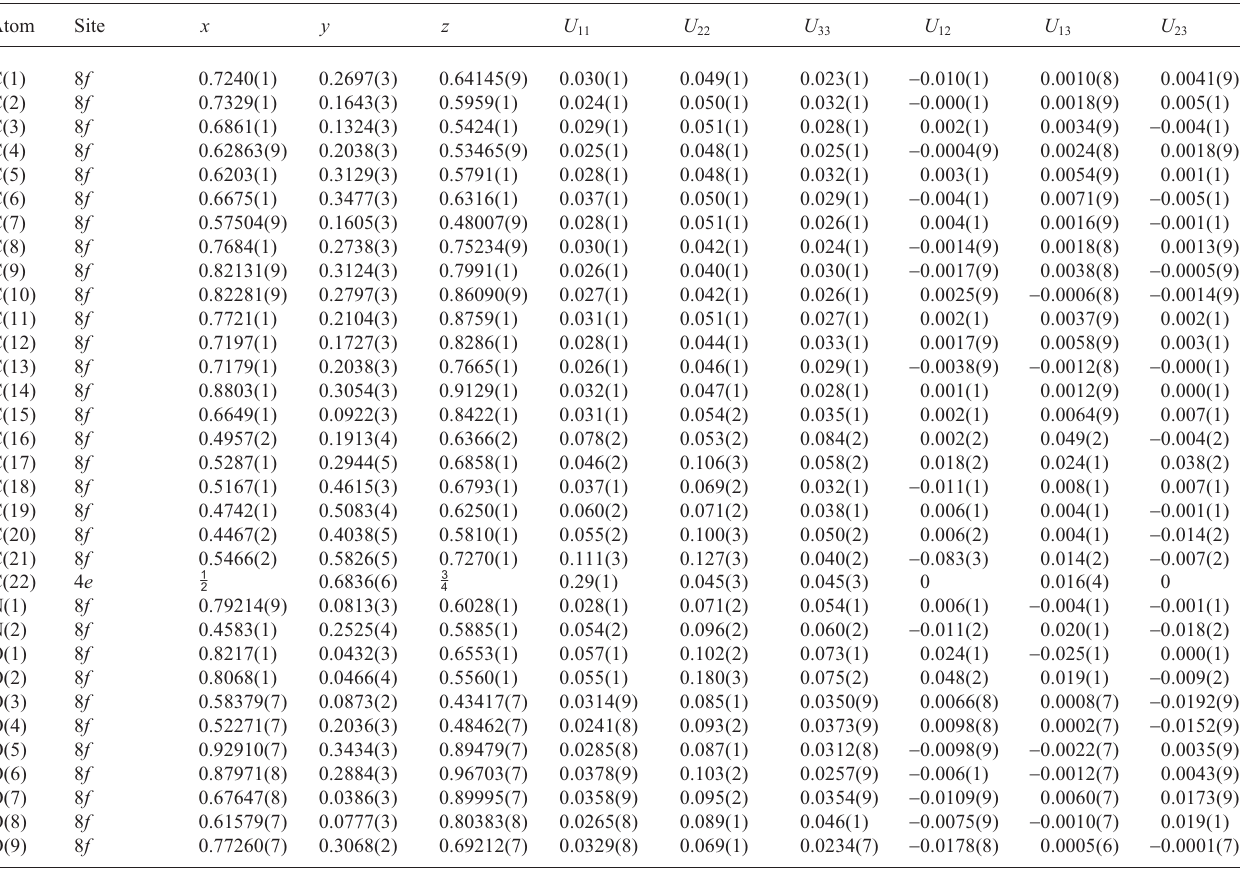
Table 3. Atomic coordinates and displacement parameters (in Å 2 )